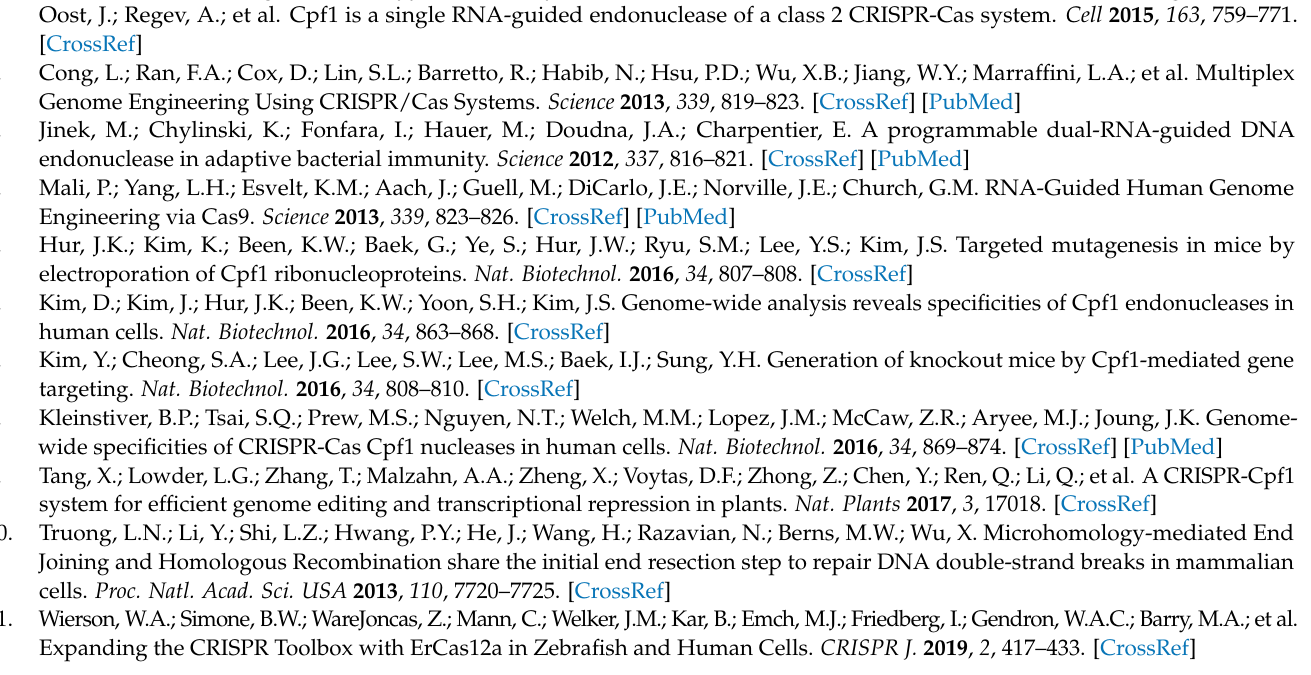
alb locus; Figure S2. ErCas12a mediates efficient MMEJ-based knockin at the zebrafish alb locus; Figure S3. ErCas12a could simultaneously achieve genome cleavage and donor linearization and mediate NHEJ-based knockin at the tbx2b locus; Figure S4. Mutagenesis capacity of N- or C- terminal fusion of TREX2 to ErCas12a; Figure S5. Evaluation of the embryo mortality after T5exo-ErCas12a system injection; Figure S6. Evaluation of KI efficiency among different fluorescent groups mediated by T5exo-ErCas12a; Figure S7. The effect of heatshock on T5exo-ErCas12a at the egfl7 locus; Figure S8. Evaluation of the indel mutation forms induced by